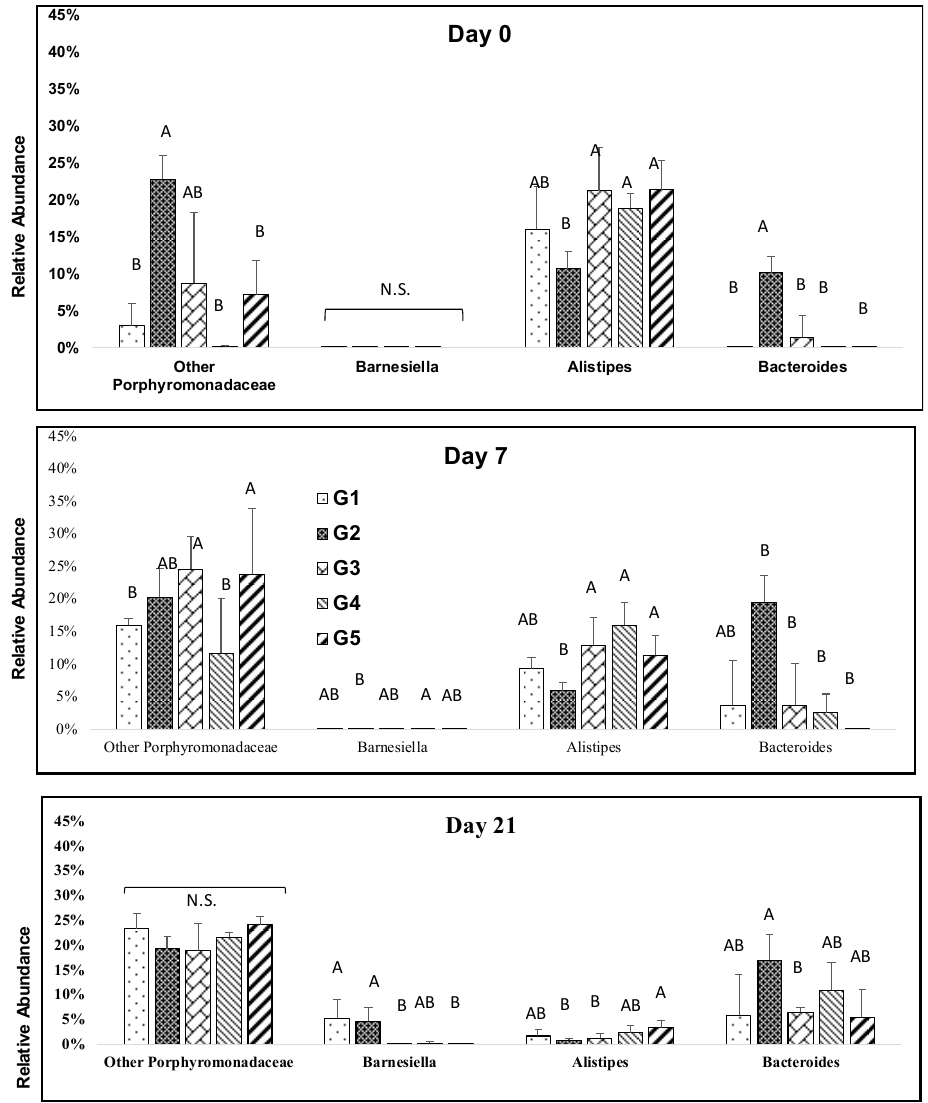
Figure 4. Impact of melanoidin malts on responsive genera relative abundances among the Figure4. Impactof melanoidinmalts on responsive generarelativeabundances amongthe Bacteroidetes. Bacteroidetes. Significant differences ( p < 0.005) are indicated by different letters ( n = 5). Significant di ff erences ( p < 0.005) are indicated by di ff erent letters ( n =